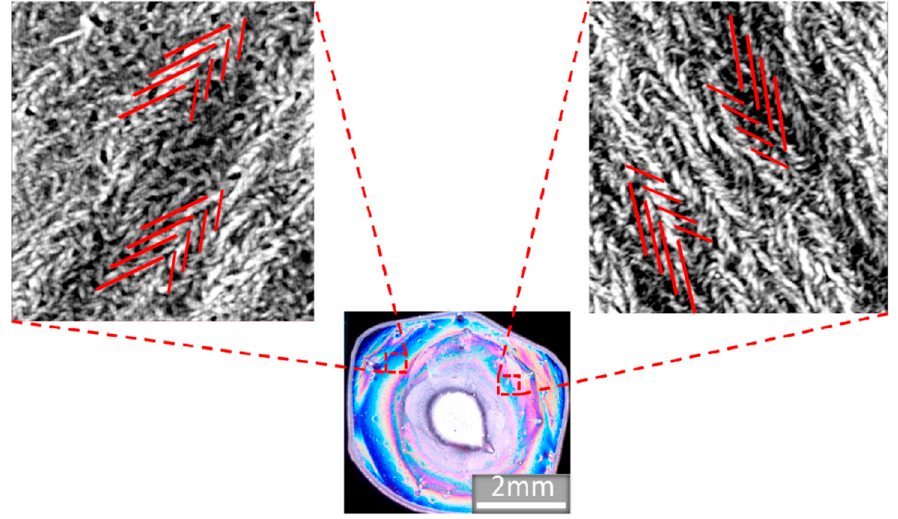
Figure 4. AFM images taken at different points along the radial color bands. Red lines representing SHN structure are drawn over AFM images to aid in visualizing the direction of the SHN bundles. Each line represents many bacteriophages bundled together to create building blocks of the self-assembled SHN film.